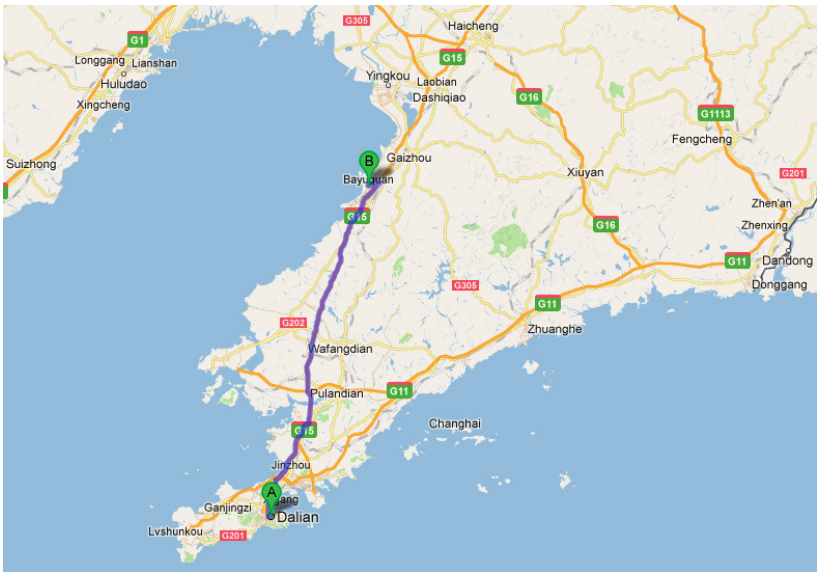
Figure 20. Experiment site of Dalian-Bayuquan district.